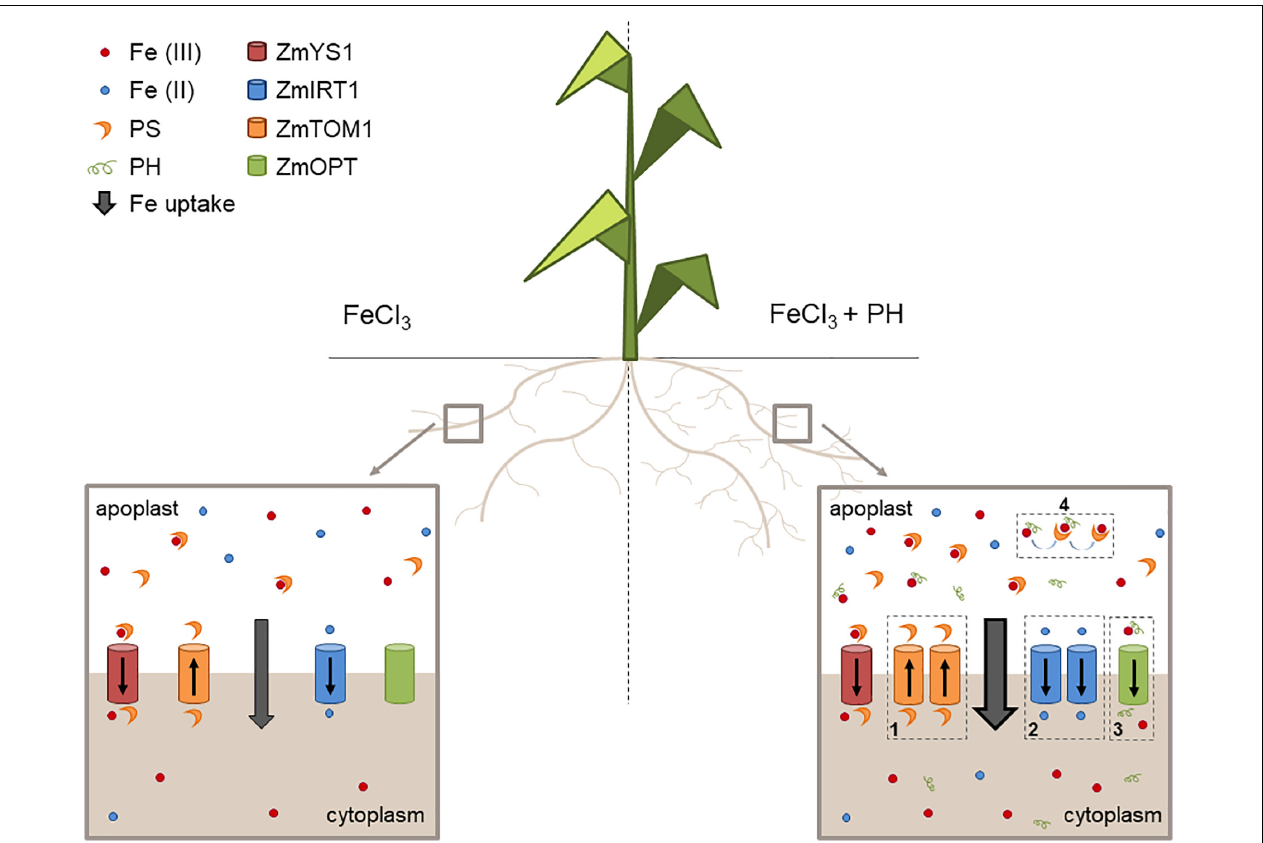
FIGURE 7 | Mechanisms of action of the PH as Fe-deficiency stress mitigator. Schematic representation of the maize root apparatus after the administration of Fe in the absence (left) or presence (right) of the PH. We show that PH increases the lateral root length (Santi et al., 2017) thus favoring soil exploration for nutrients. In addition, PH treatment maintains a higher expression of genes encoding (1) the transporter involved in PS efflux (ZmTOM1) and (2) the transporter of Fe(II) (ZmIRT1), possibly reduced by plasma membrane Fe reductase activities (not shown in the scheme). The PH tends to increase the expression of (3) putative Fe-peptide transporter (ZmOPT). The PH can also chelate Fe and facilitate the exchange of Fe to the PSs (4).